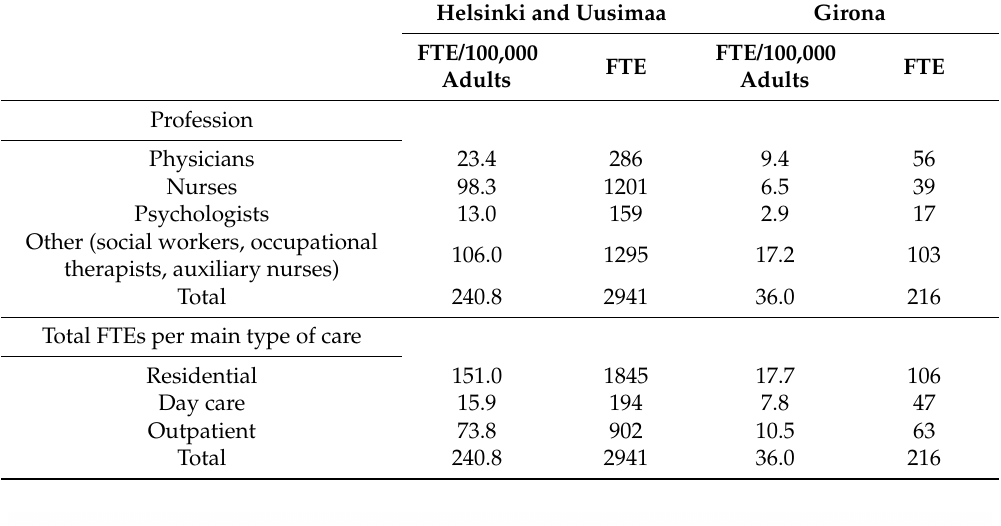
Table 3. Personnel in full-time-equivalents (FTE) per profession and per main type of care.